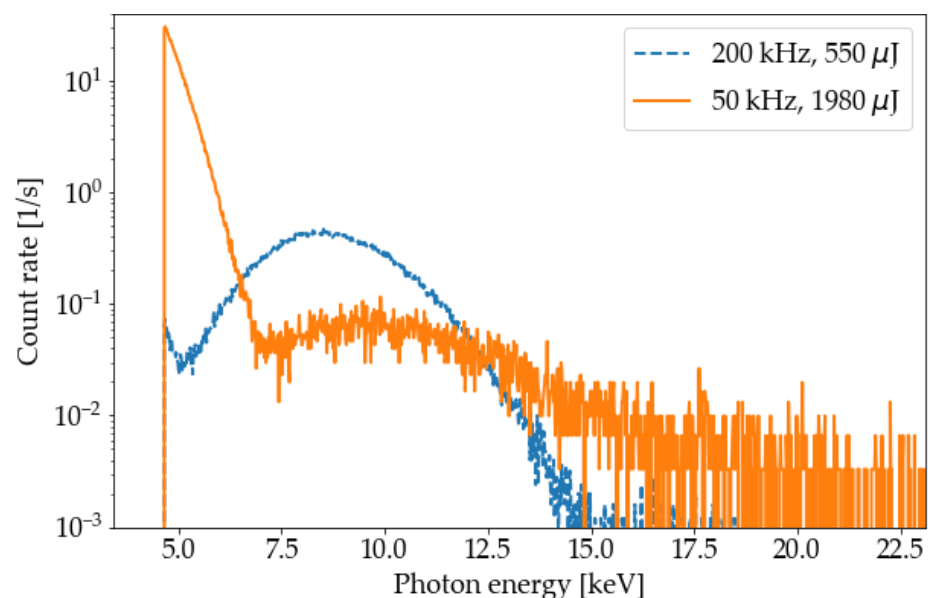
Figure 8. Pulse height spectra measured for the combination of two different USP-laser pulse energies and laser repetition rates: 550 µ J and 200 kHz (blue curve), 1980 µ J and 50 kHz (orange curve). The number of photons per channel with an energy bandwidth of 20 eV was divided by the total USP-laser processing time, to make the two spectra comparable. The increase in irradiance due to the higher pulse energy causes an energetic shift of the maxima of the spectra to higher photon energies. The increase of count rate in the low-energy region (between 5 keV and 7 keV) for the 50 kHz process is most likely caused by electronic noise due to an insufficient shielding of the CdTe detector. Overall, the recorded number of X-ray photons per second is very low, which was also confirmed in separate dose rate measurements with the Automess 6150AD-b/E dosemeter (see Table 1).